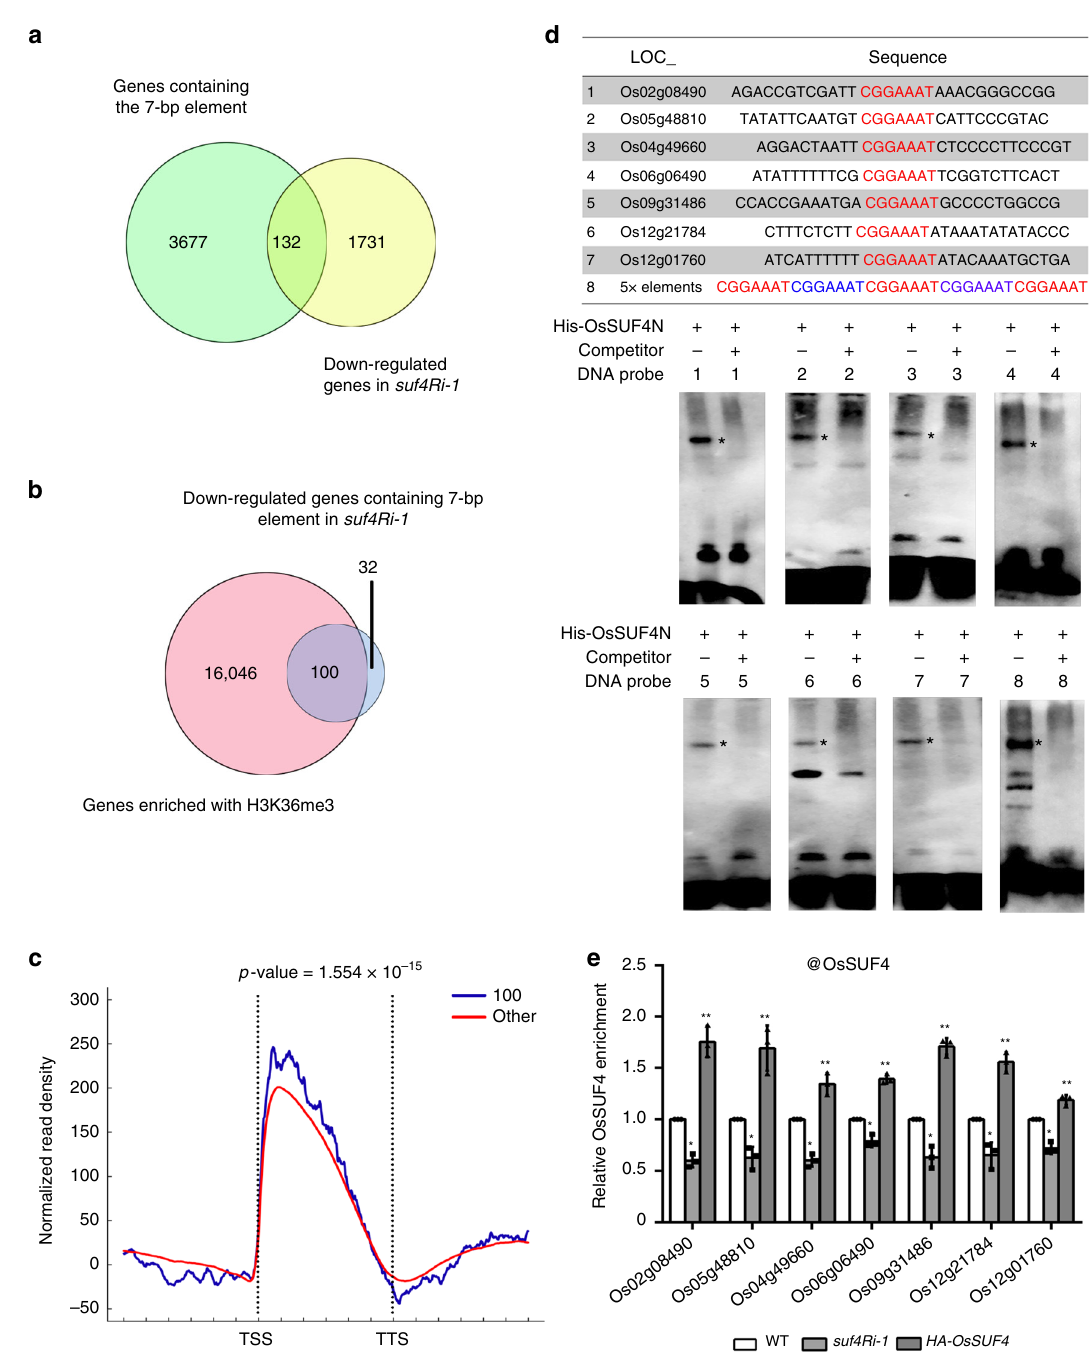
Fig. 7 OsSUF4 binds to more target genes. a Venn diagram showing comparison of total genes containing the 7-bp element in the rice genome (green) and the down-regulated (over 1.5-fold) genes in the suf4Ri-1 mutant plants (yellow). b Venn diagram showing comparison of total genes enriched of H3K36me3 in the wild-type rice genome (rose) with genes containing the 7-bp element and down-regulated in suf4Ri-1 (blue). c H3K36me3 distribution pattern of the 100 genes identi fi ed in ( b ) as compared to the other 16,046 H3K36me3-enriched genes in WT rice. The indicated P -value was calculated by the Kolmogorov – Smirnov test. d EMSA analysis with puri fi ed His-OsSUF4N and probes in the upper table. Unlabeled probes were used as competitors (100- fold excess). Asterisks indicate the position of shifted bands. e ChIP analysis for OsSUF4 enrichment at the promoter regions of the seven genes using an antibody against OsSUF4 in WT, suf4Ri-1 , and P Ubi :: HA-OsSUF4 plants. Values are the mean ± SD of three individual biological replicates normalized to the internal control OsUbiquitin5 . *Represents signi fi cant differences between WT and suf4Ri-1 (Student ’ s t -test: * P < 0.01). **Represents signi fi cant differences between WT and P Ubi :: HA-OsSUF4 (Student ’ s t -test: ** P < 0.01). Source data are provided as a Source Data fi